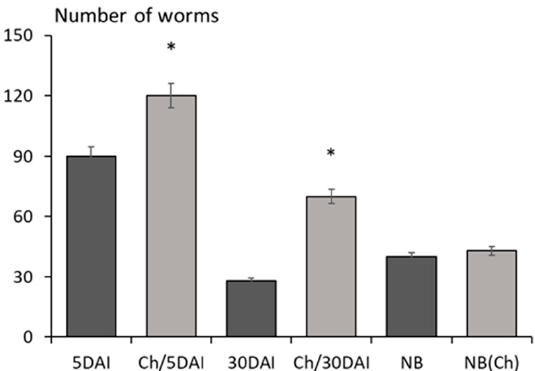
(30 DAI) in mice infected with T. spiralis ; NB: newborn larvae delivered by females isolated from control infection; NB(Ch): newborn larvae delivered by females isolated from mice infected and treated with chitosan. (*) p < 0.05, chitosan vs.